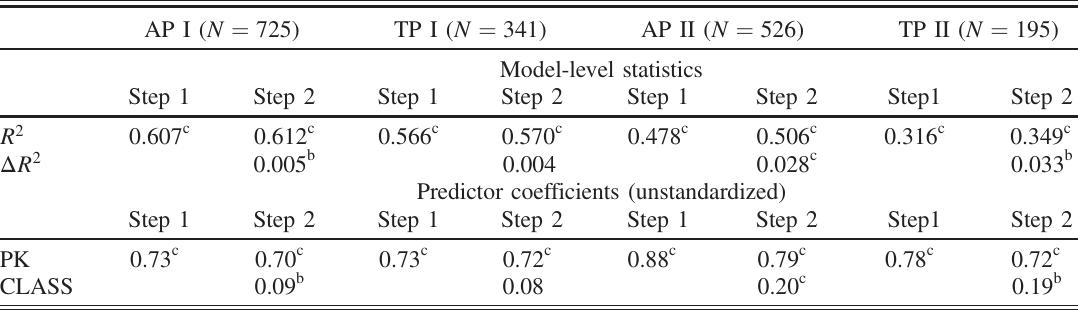
TABLE II. Regression-model summaries predicting late-semester concept inventory (FCI and BEMA) scores from prior knowledge measures and overall CLASS scores. The notations on the table are as follows: Fall Active Physics (AP I); Fall Traditional Physics (TP I); Spring Active Physics (AP II); Spring Traditional Physics (TP II); number of observations ( N ); change in R 2 between step 1 and step 2 ( Δ R 2 ); prior knowledge (PK) (FCI in AP I and TP I, BEMA in AP II and TP II). Prior knowledge alone was entered in step 1 of each model, and then overall CLASS was added in step 2.